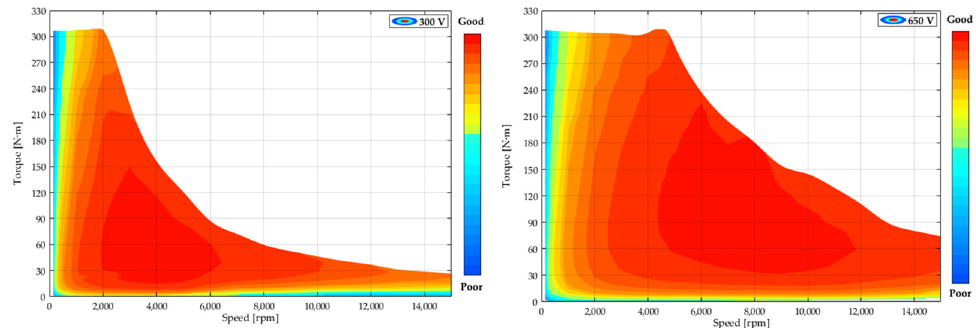
Figure 10. Efficiency effected by voltage.